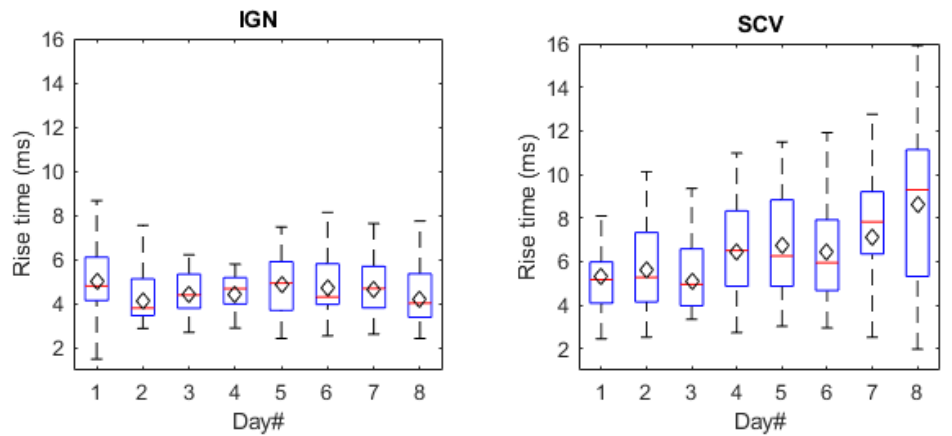
Figure 10. Rise times computed for the complete data set at sensor locations IGN and SCV.